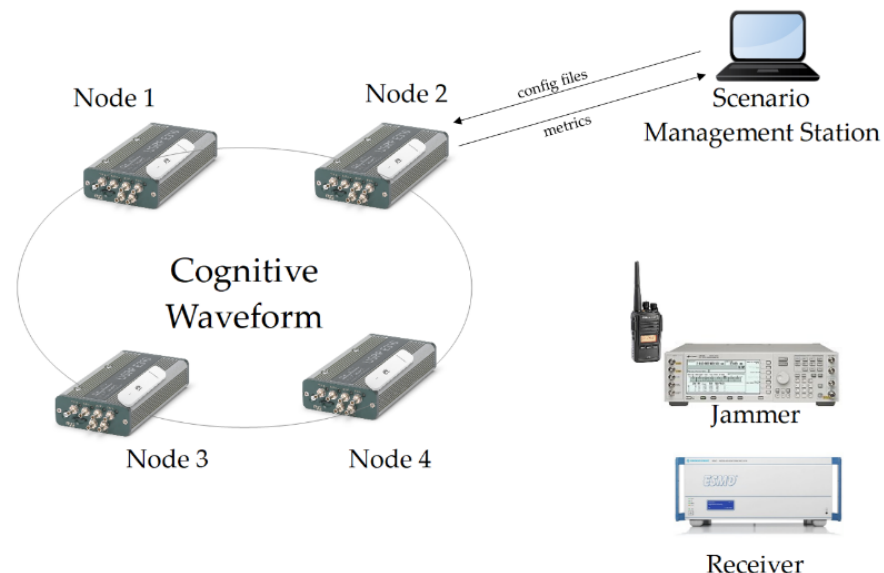
Figure 11. Testbed architecture.